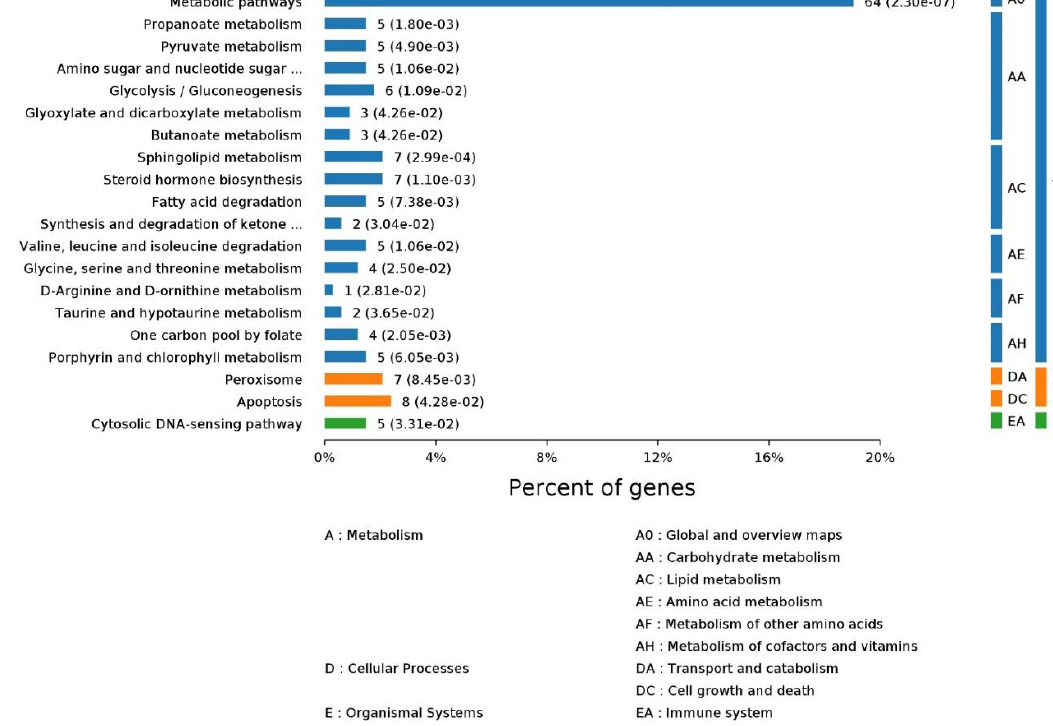
Figure 7. The KEGG (Kyoto Encyclopedia of Genes and Genomes) pathway enrichment of Homo’s ligand-binding proteins. The pictures were made with OmicsBean.